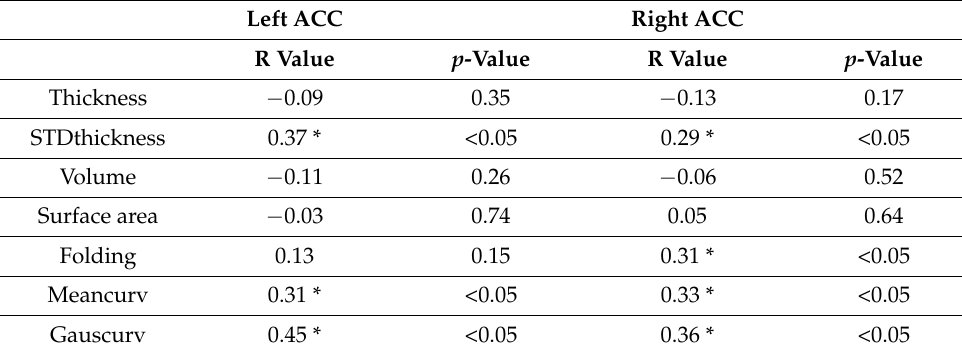
Table 2. Correlation of surface morphological parameters with age. Left ACC Right ACC R Value p -Value R Value p -Value Thickness − 0.09 0.35 − 0.13 0.17 STDthickness 0.37 * <0.05 0.29 * <0.05 Volume − 0.11 0.26 − 0.06 0.52 Surface area − 0.03 0.74 0.05 0.64 Folding 0.13 0.15 0.31 * <0.05 Meancurv 0.31 * <0.05 0.33 * <0.05 Gauscurv 0.45 * <0.05 0.36 *